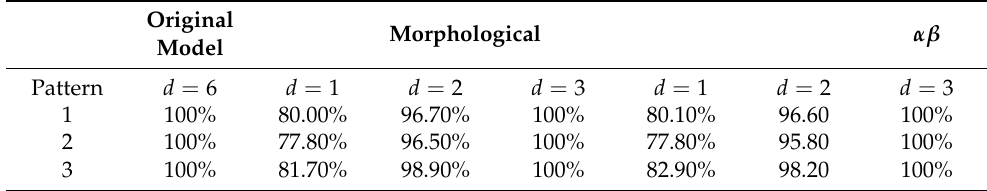
Table 9. Performance of the proposed model vs. original model in 120 × 120 binary